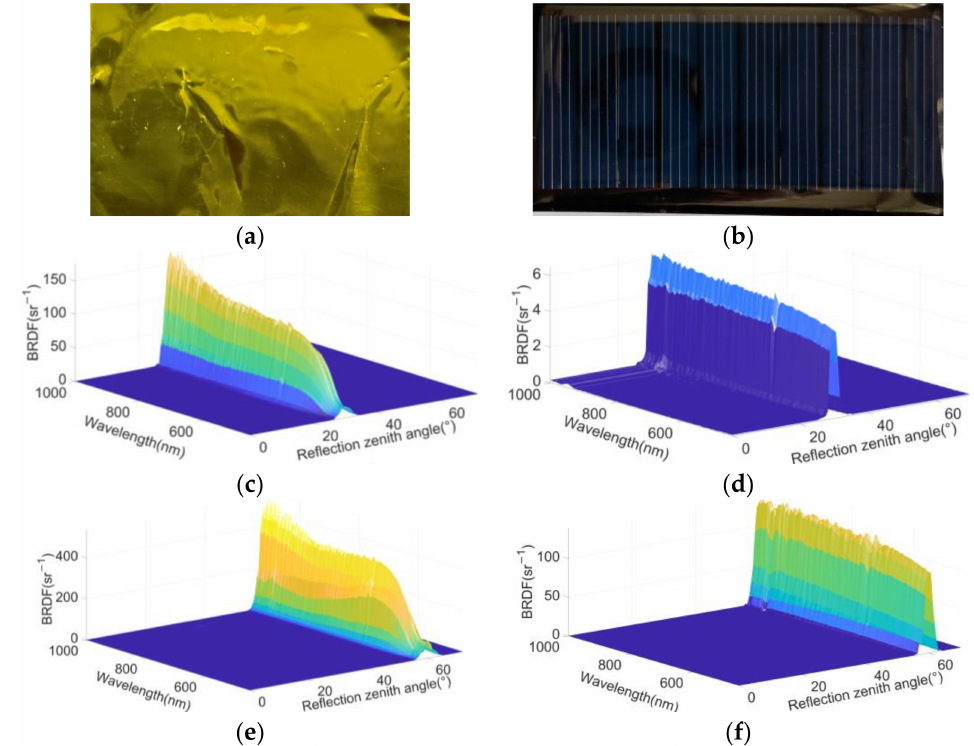
Figure 3. Material samples and some measured BRDF data of yellow thermal control material and silicon solar cells. The brighter the color, the greater the BRDF value. ( a ) Sample of thermal control material; ( b ) sample of silicon solar cells; ( c ) measured BRDF of thermal control material when θ i is 30 ◦ ; ( d ) measured BRDF of silicon solar cells when θ i is 30 ◦ ; ( e ) measured BRDF of thermal control material when θ i is 60 ◦ ; ( f ) measured BRDF of silicon solar cells when θ i is 60 ◦ . At the same time, the above measured BRDF data are theoretically modeled using the microfacet BRDF model [14,15]. The microfacet BRDF model includes the